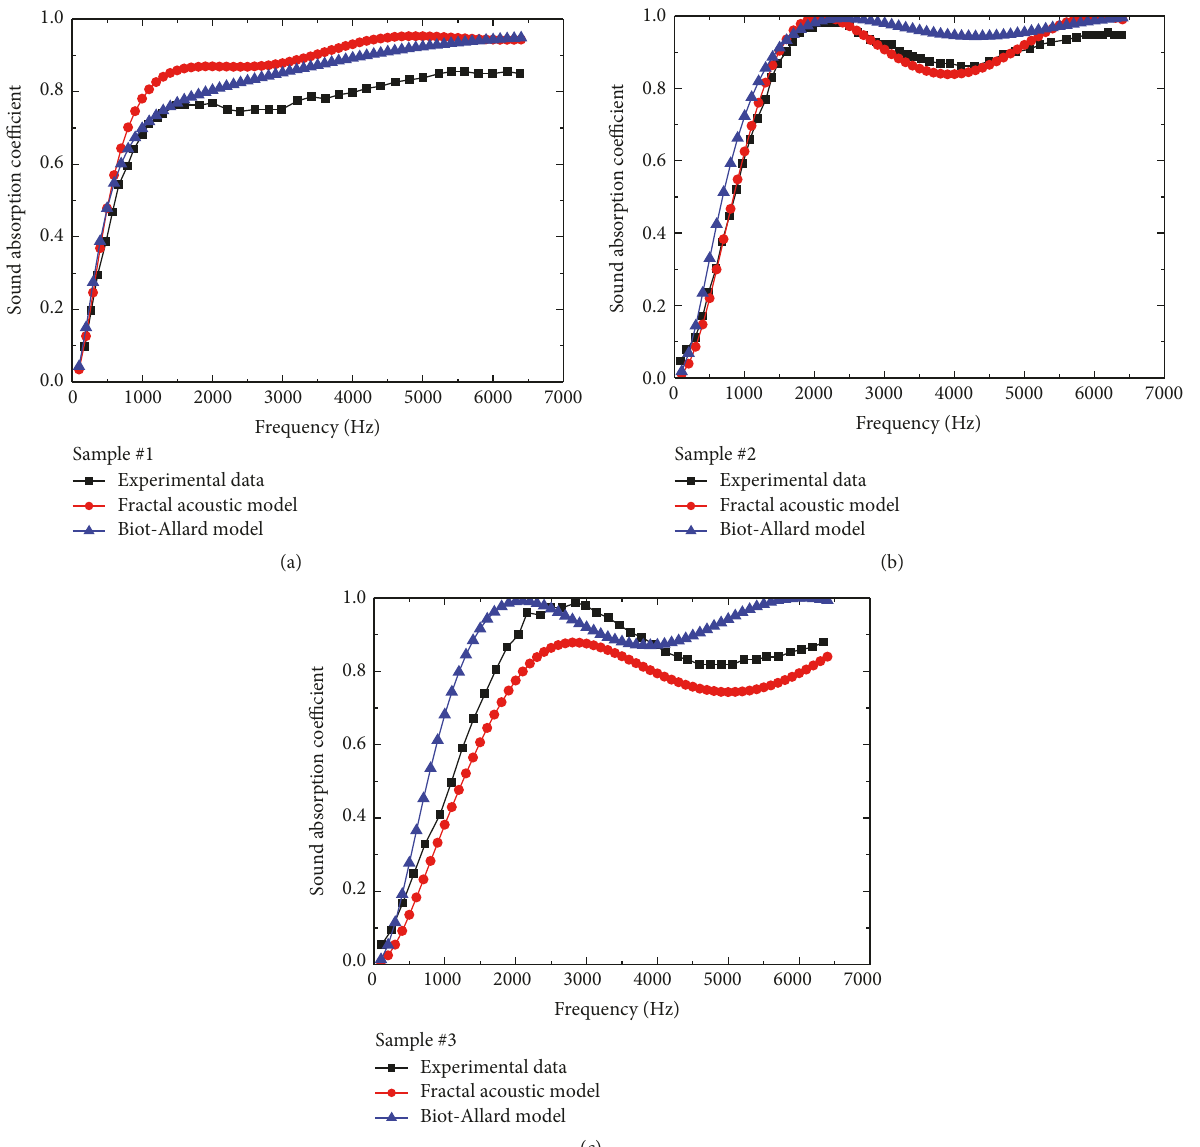
Figure 14: Comparisons between the calculated and measured sound absorption coefficients of the PFMM samples: (a) sample #1, (b) sample #2, and (c) sample #3.